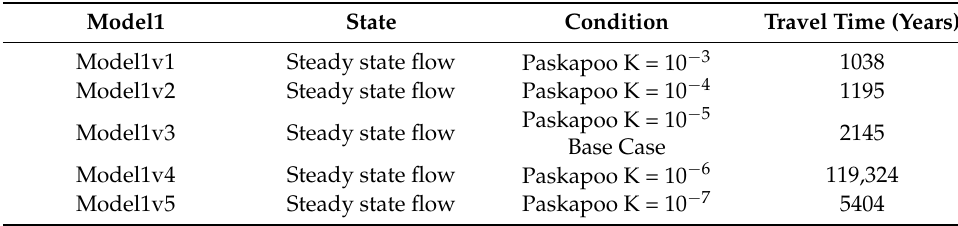
Figure 10. Transient Flow BC with varying heads: time variable constant head as function of glacier height over time based on Figure 9 (simulations 4). The time varying constant heads were assigned to six separate zones shown above and described in Table 4 with h values for year 2020. Table 4. Sensitivity analysis for the Paskapoo Fm.